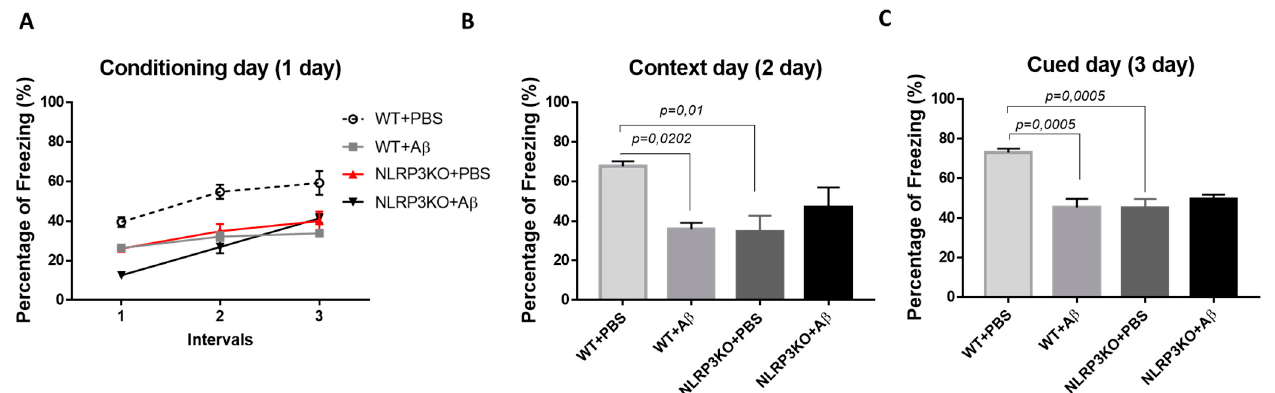
Figure 1. Results of behavioral testing in the Fear conditioning Test. Percentage of freezing on ( A ) the first conditioning day, ( B ) the second context day, ( C ) third signal day. WT—wild type control mice, NLRP3 KO—NLRP3 knockout mice, ns—not significant. A β —amyloid beta injection, PBS—phosphate buffered saline injection (sham operation).